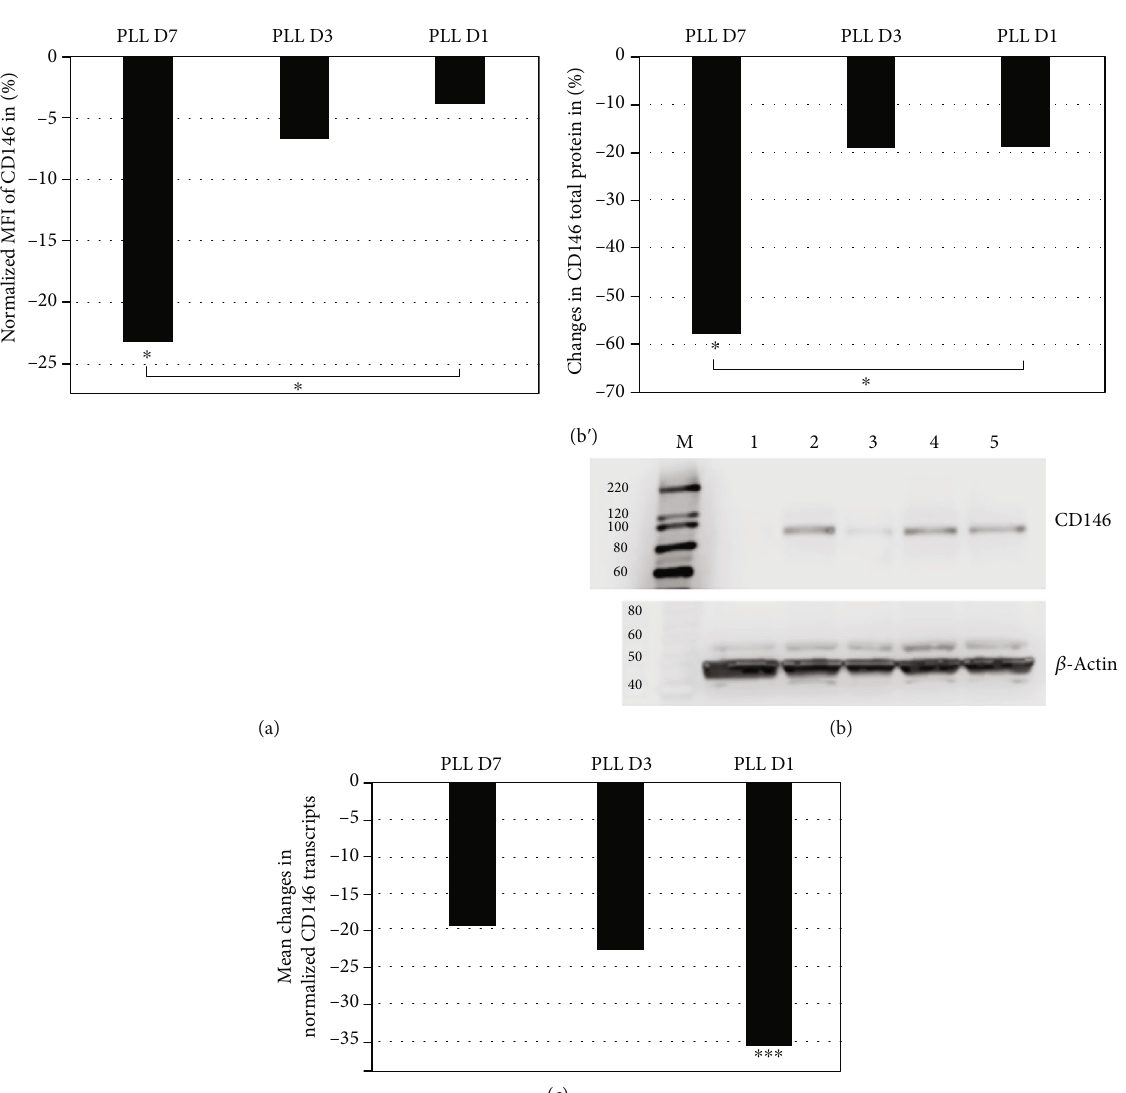
Figure 3: Time line of PLL e ff ects on the expression of CDC146. The pMSC from 4 donors was expanded in LM to their second passage and further expanded in LM+5% (vol/vol) PLL. Controls were incubated in LM. (a) The expression of CD146 on cells surfaces was investigated by fl ow cytometry. Seven days after addition of PLL, the MFI of the CD146 expression dropped signi fi cantly in comparison to pMSCs in LM and in comparison to cells 1 day after addition of PLL ( P < 0 : 05 each). (b) The expression of the total CD146 protein was investigated by immunoblot. Seven days after addition of the PLL total protein of the CD146 expression dropped signi fi cantly in comparison to pMSCs in LM and in comparison to cells 1 day after addition of PLL ( P < 0 : 05 each). (B ’ ) A representative immunoblot is shown in the lower right: CD146 is not detected in control cells (lane 1), but in pMSCs expanded for 7 days in LM (lane 2), almost not in pMSCs expanded for 7 days in LM +PLL (lane 3). CD146 is detected in pMSCs expanded for 72 hours (lane 4) or 24 hours (lane 5) in LM+ PLL. Detection of ß- actin served as loading control. Size markers are shown in lanes M. The molecular weight of proteins separated by SDS-PAGE is noted on each blot. (c) The expression of transcripts encoding CD146 was enumerated by RT-PCR. After 24 hours of incubation in LM+PLL, a signi fi cant drop in CD146 transcripts was noted in comparison to pMSCs in LM ( P < 0 : 005 ). After 3 and 7 days, CD146 encoding transcript increased somewhat but stayed well below the levels recorded in pMSCs in